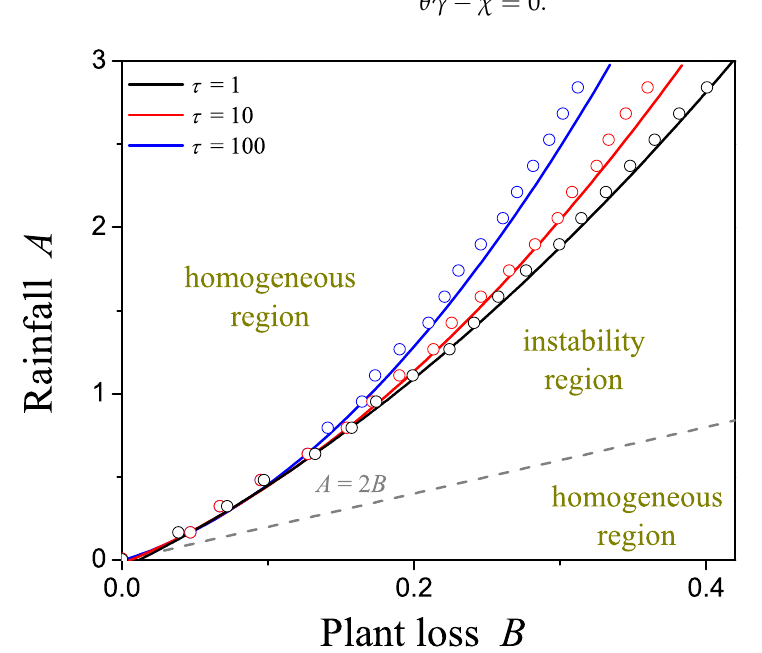
Figure 5. The locus at which spatial bifurcations occur for different values of inertial time τ . Solid lines represent the numerically computed loci, whereas symbols denote the theoretically approximated predicted ones. Fixed parameters: ψ =